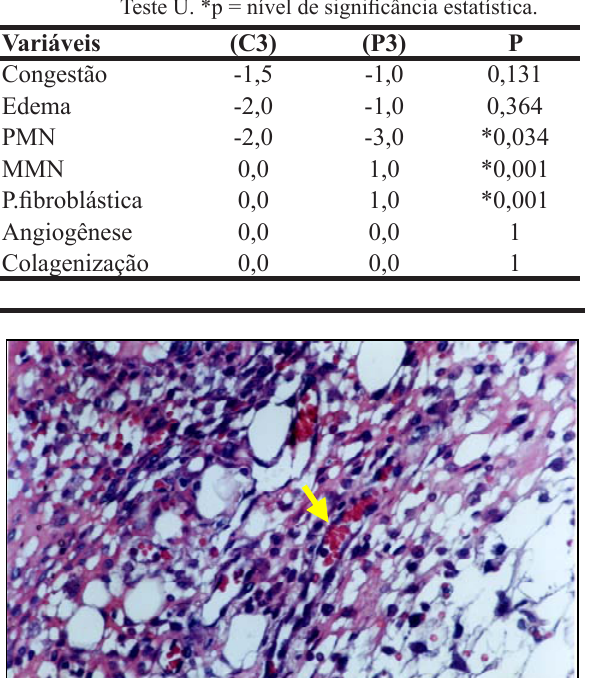
TABELA 1 – Análise intergrupo das médias das variáveis mi - croscópicas dos subgrupos C3 e P3. Mann-Whitney;